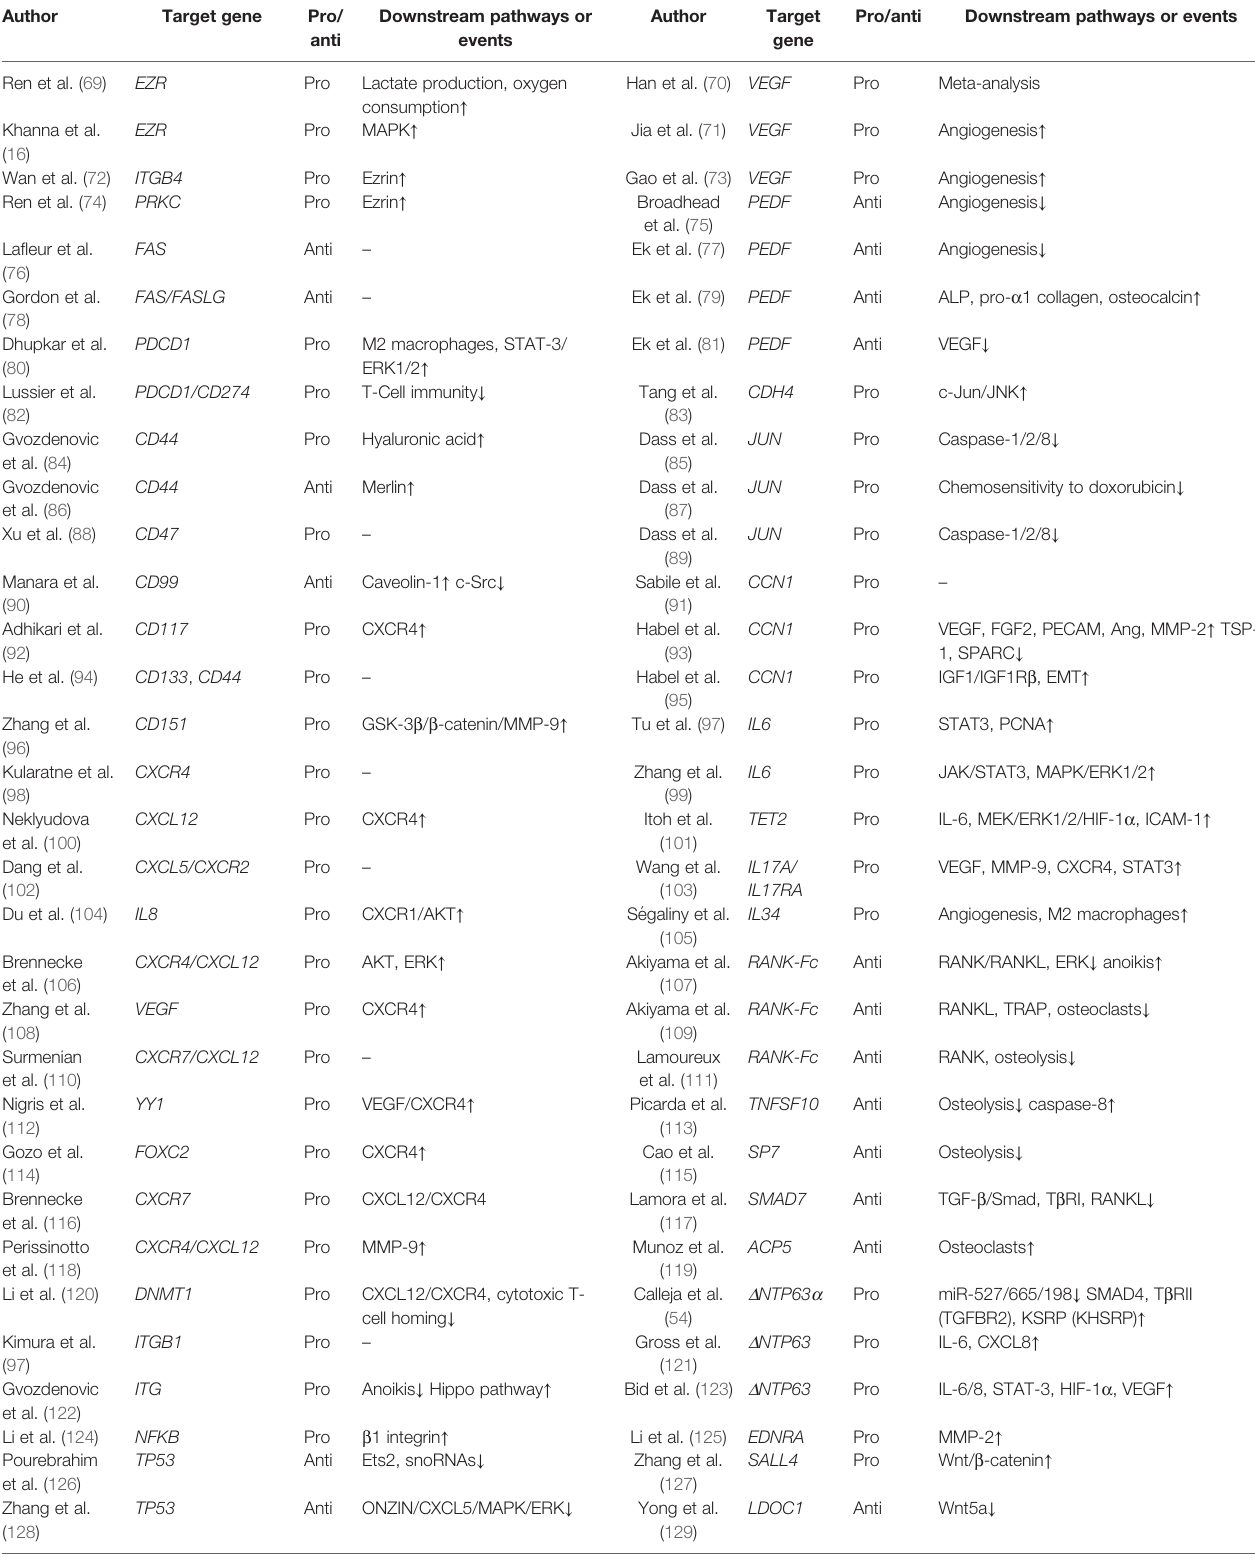
TABLE 1 | Summary of genes and signaling pathways involved in osteosarcoma